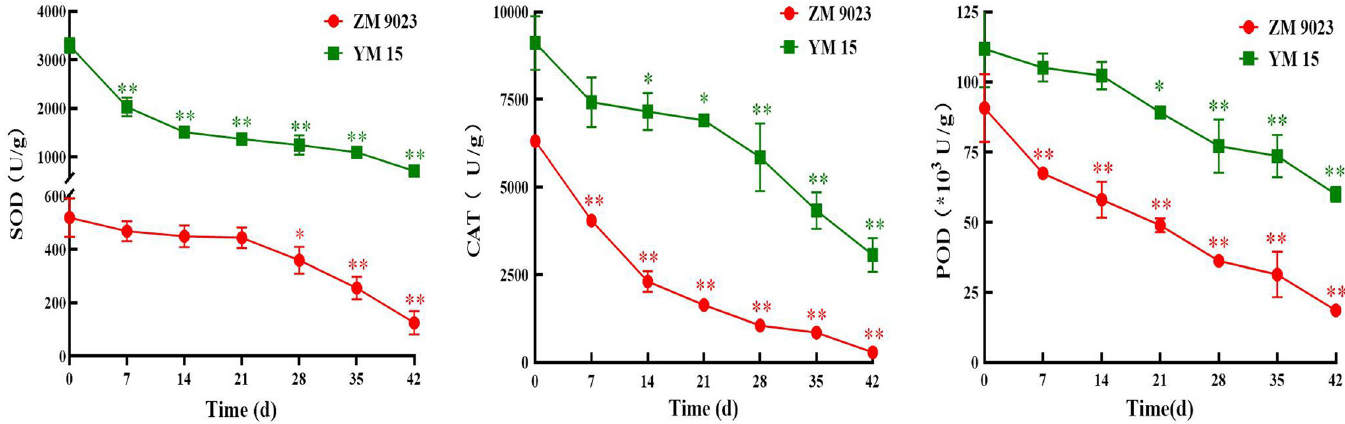
Fig 4. Changes in the antioxidant enzyme activities of the wheat cultivars ZM 9023 and YM 15 during artificial aging. At least three independent experiments were performed; data are shown as mean ± SD. � p < 0.05; �� p < 0.005.